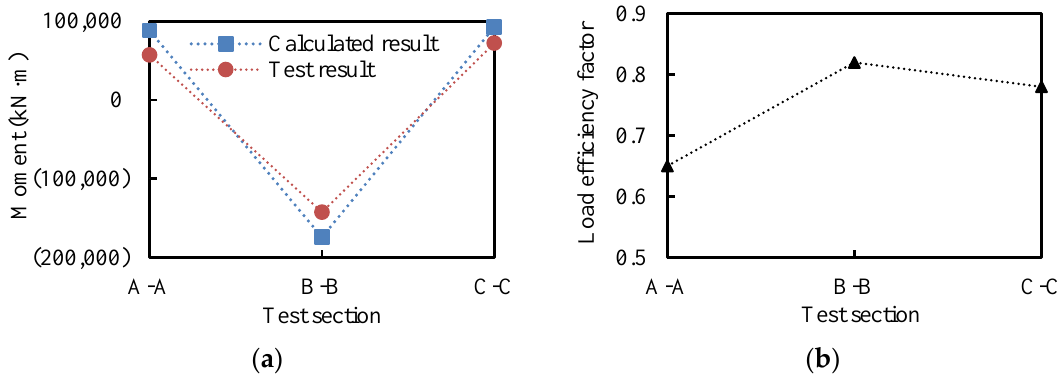
Figure 5. ( a ) Maximum moment of each section under the most unfavorable loading case; ( b ) Experimental results of the load efficiency factor.